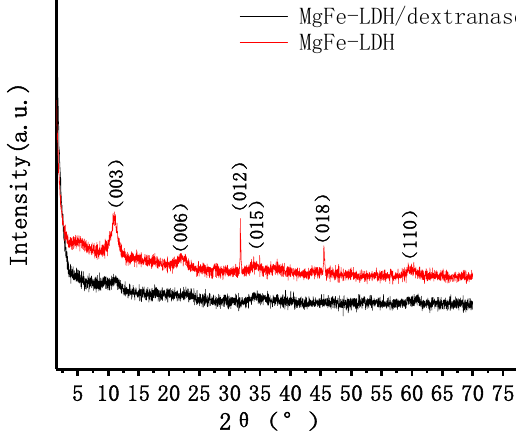
Figure 7. XRD patterns of Mg/Fe-LDH and Mg/Fe-LDH/dextranase.